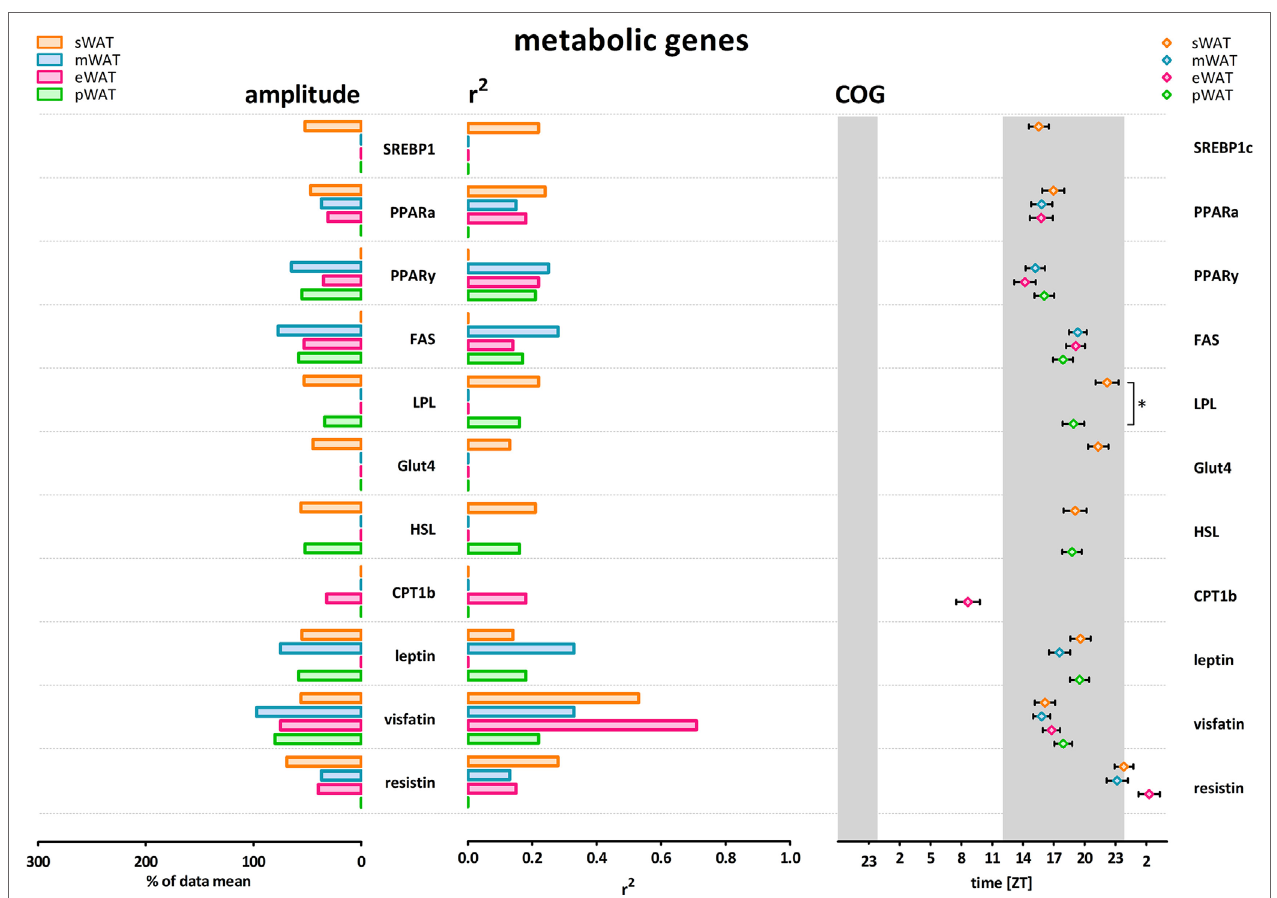
FigUre 2 | Metabolic genes show modest amplitude, modest r 2 (inter-individual variability) and higher variability in center of gravity (COG) in subcutaneous and intra-abdominal white adipose tissue (WAT) depots. LPL peaked significantly earlier in pWAT compared to sWAT (two-tailed t -test F = 1,133; p = 0.0342; difference = 3.2 ± 1.5 h) sWAT; subcutaneous, mWAT; mesenteric, eWAT; epididymal, pWAT; perirenal. Gray bars indicate the dark phase (ZT 12–24). Absence of amplitude, R 2 , and COG values indicates absence of significant rhythmicity, not absence of gene expression. Individual expression curves for each gene and WAT depot can be found in Figure S1 in Supplementary